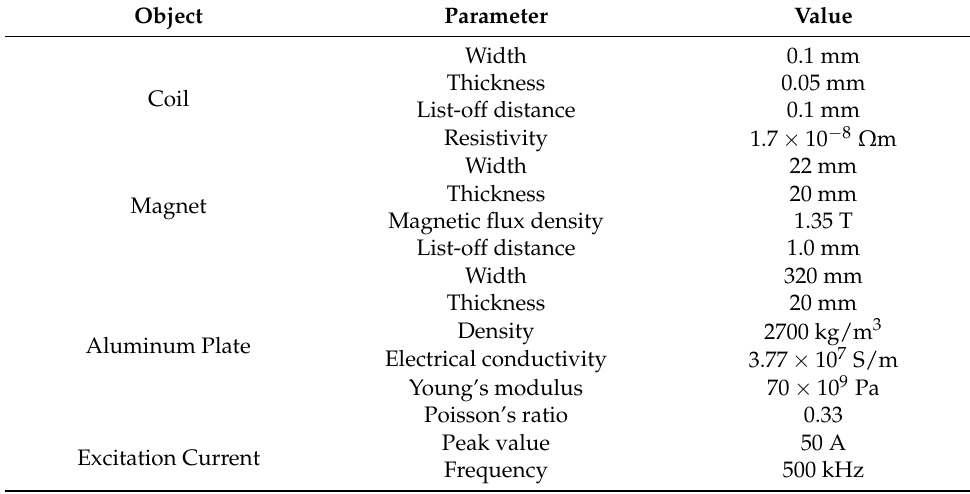
Table 1. Parameters and values of surface wave EMATs in the finite element